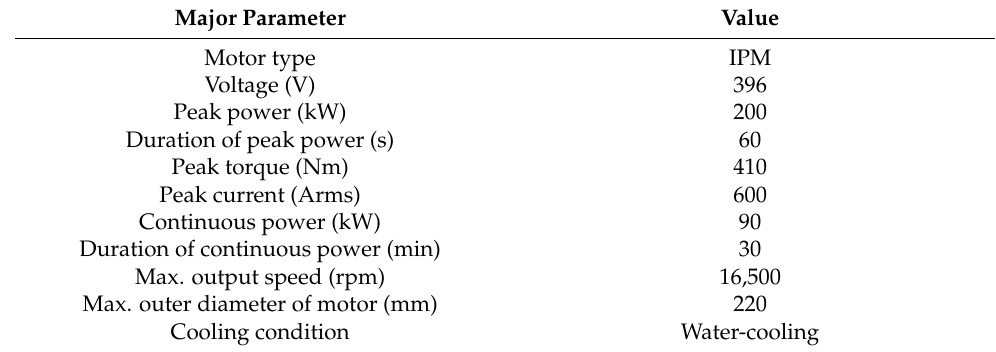
Table 4. Performance requirement of motor.